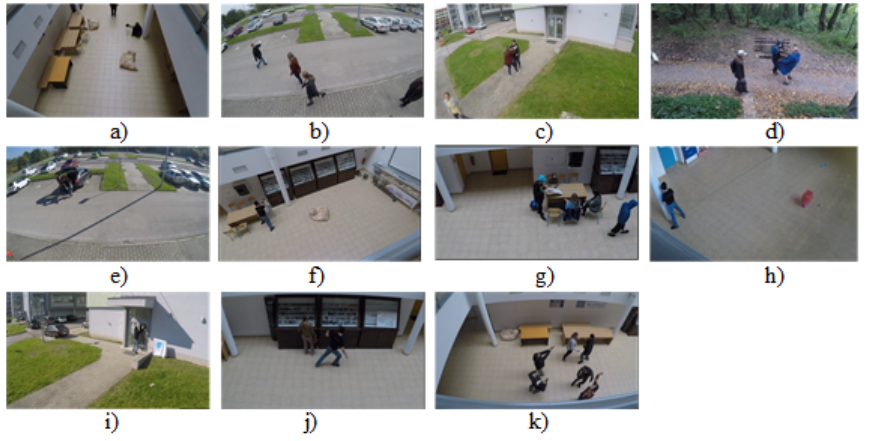
Figure 6. Abnormal Activities Dataset: ( a ) Begging, ( b ) Drunkenness, ( c ) Fight, ( d ) Harassment, ( e ) Hijack, ( f ) Knife Hazard, ( g ) Normal Videos, ( h ) Pollution, ( i ) Property Damage, ( j ) Robbery, ( k )